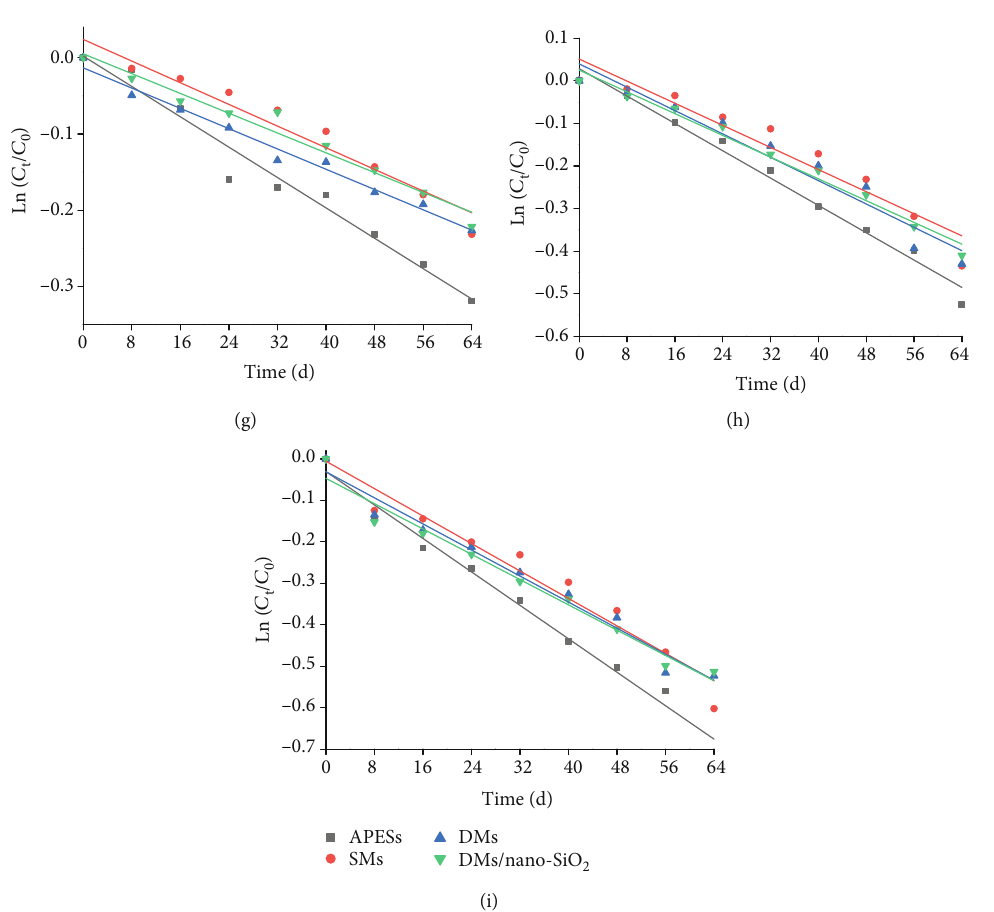
during di ff erent storage conditions. (a) The fi rst-order 2